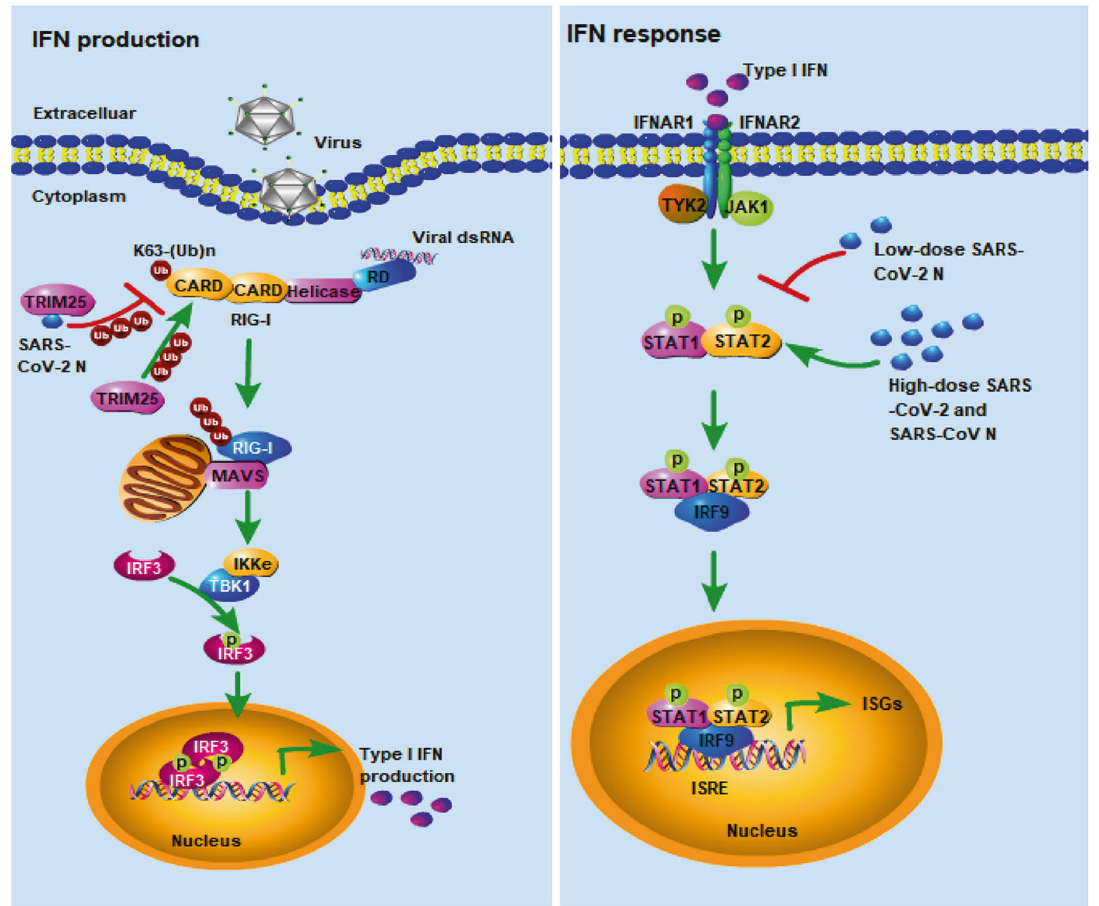
Fig. 9 Schematic depiction of the dual regulation role of SARS-CoV-2 nucleocapsid protein against IFN-I signaling. The low-dose SARS-CoV-2 N protein suppresses innate immune response by reducing RIG-I ubiquitination through interacting with TRIM25, and reducing STAT1/STAT2 phosphorylation and nuclear translocation; whereas high-dose SARS-CoV-2 and SARS-CoV N proteins promote innate immune response by enhancing the phosphorylation and nuclear translocation of STAT1 and